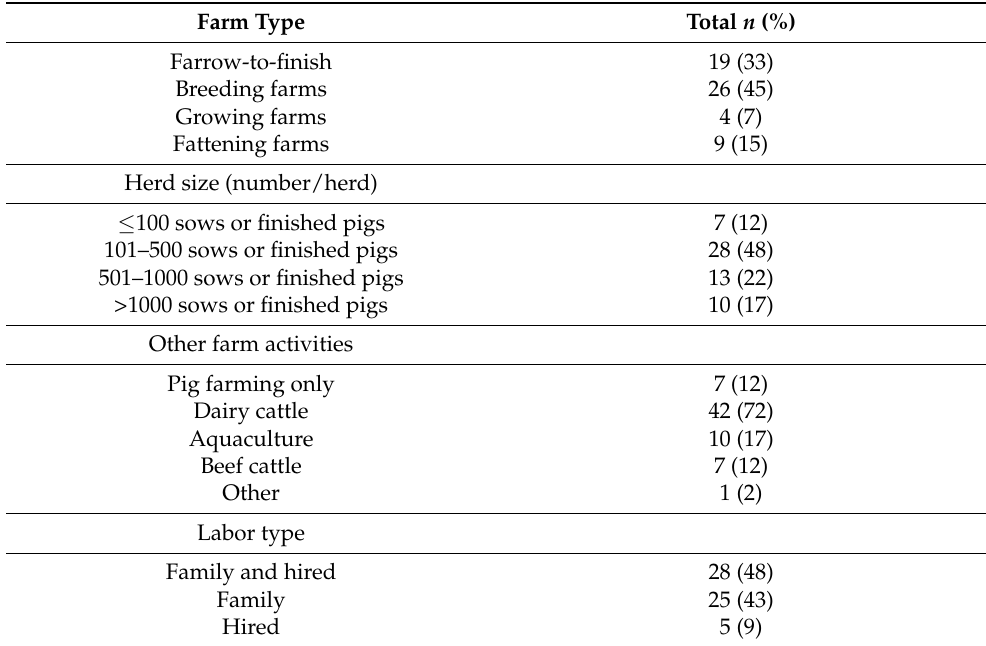
Table 1. Demographic characterization of the visited farms ( n =